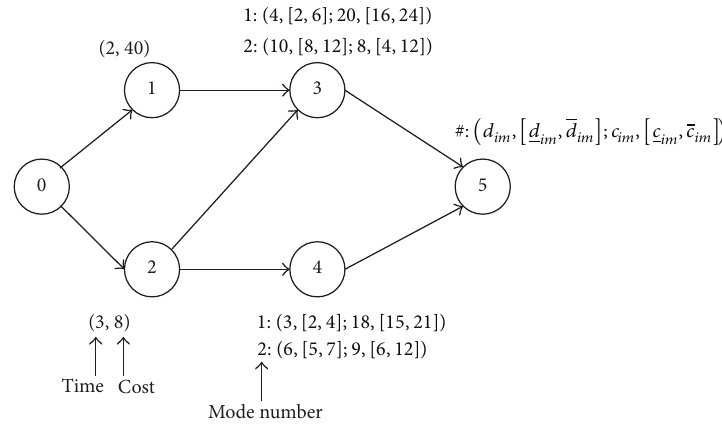
Figure 1: The example project network.